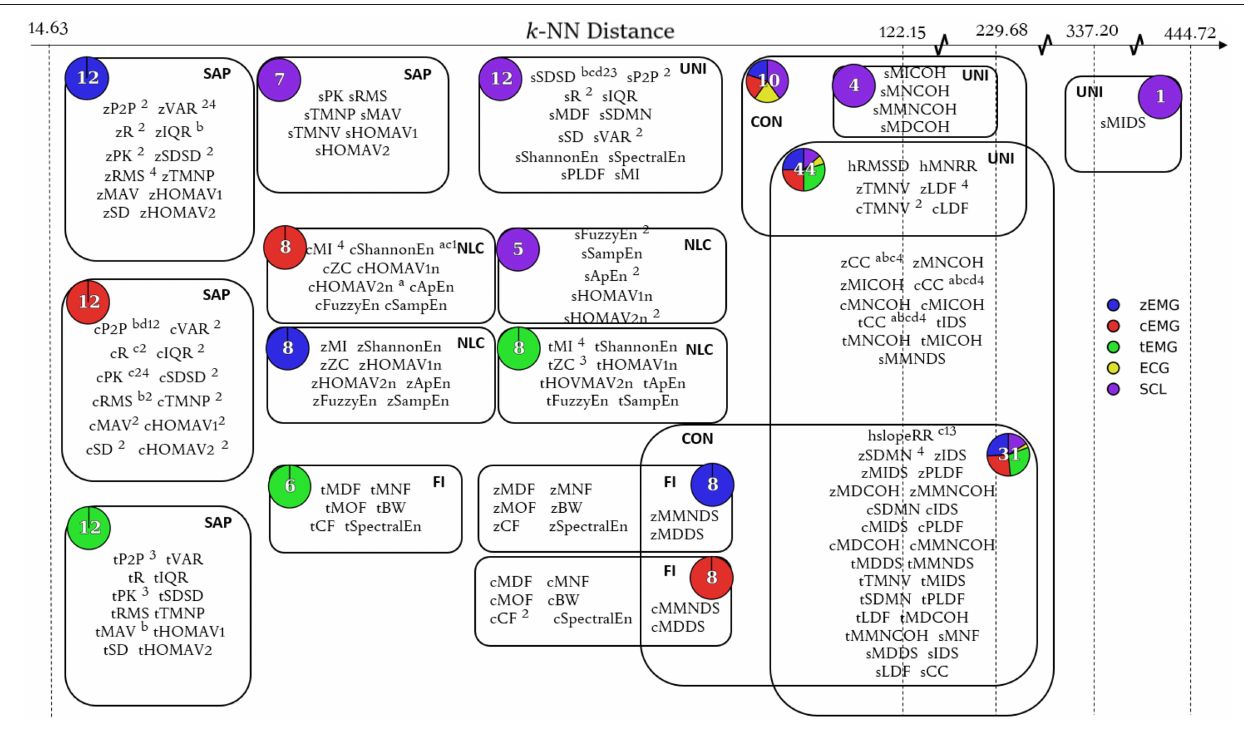
FIGURE 4 | Topological feature chart. Node expansion highlighting key features selected within the SFS protocols for all classification tasks (FSa-FSd) and feature sets identified through other works of literature (FS1-FS4). Features belonging to defined feature sets were identified through superscripts (FSa: a , FSb: b , FSc: c , FSd: d , FS1: 1 , FS2: 2 , FS3: 3 , FS4: 4 ). Node composition by modality is shown by pie charts. Node functional group is denoted by bold acronym (SAP, Signal Amplitude and Power; NLC, Nonlinear Complexity; FI, Frequency Information; UNI, Unique; CON,